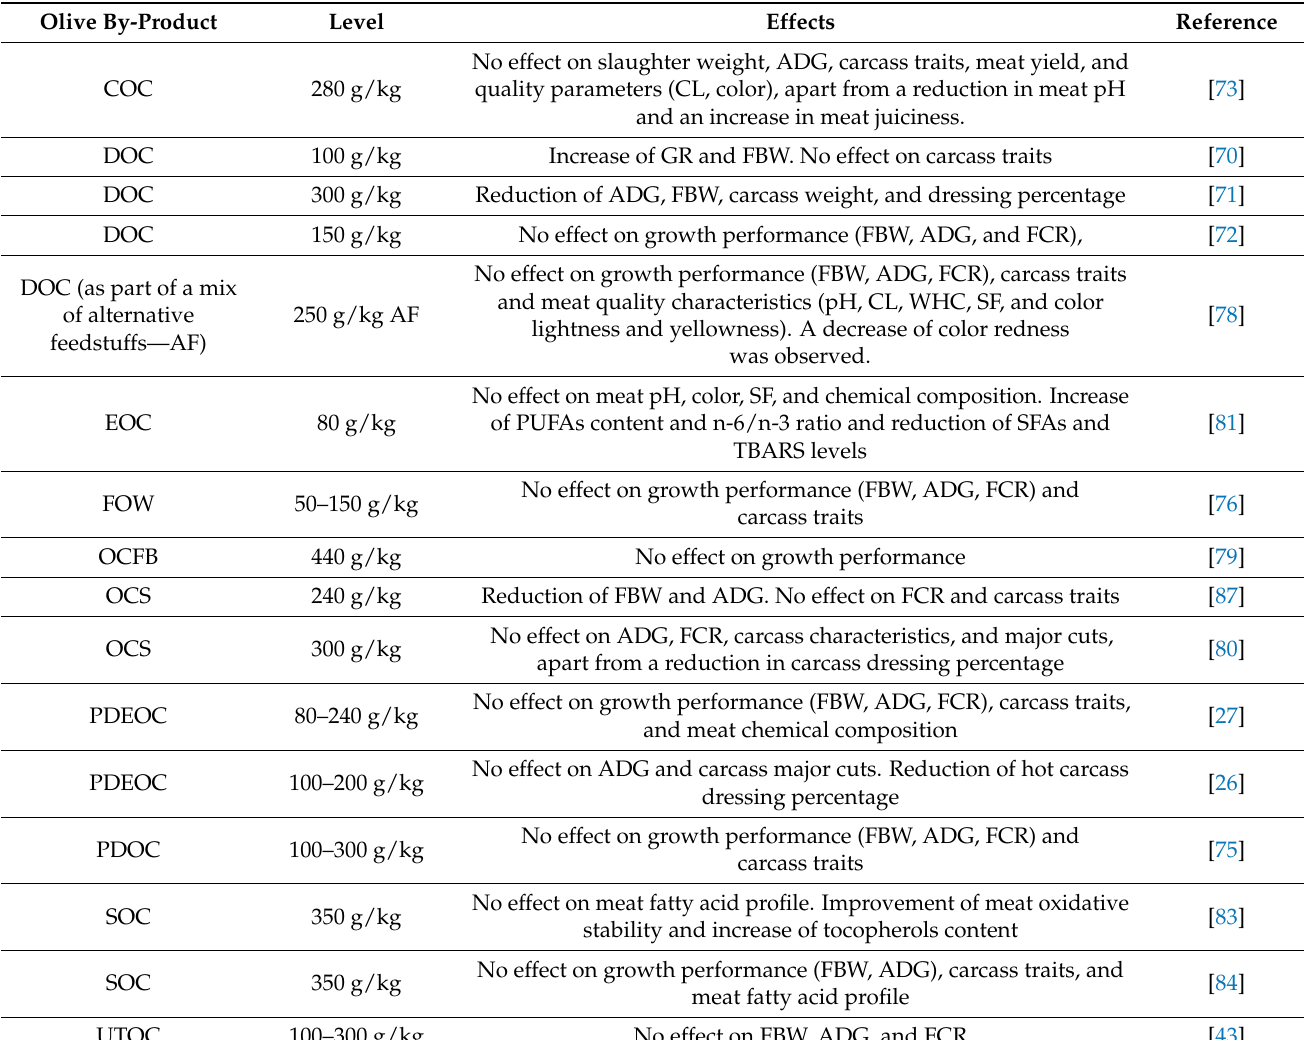
Table 3. The effects of olive by-products dietary supplementation on growth performance, carcass traits, and meat properties of